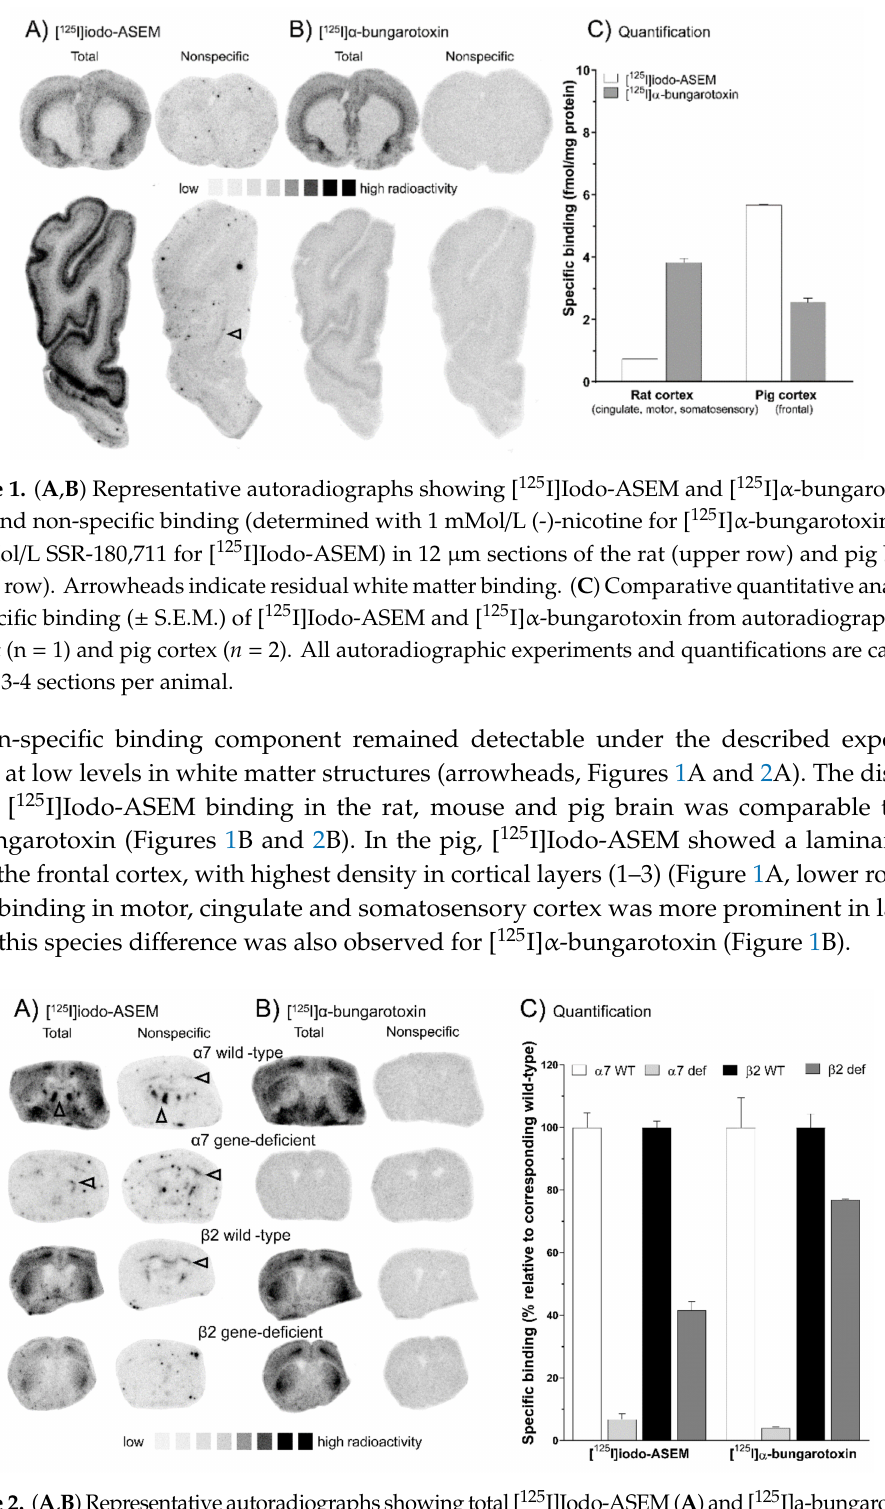
Figure 2. ( A , B )Representativeautoradiographsshowingtotal[ 125 I]Iodo-ASEM( A )and[ 125 I]a-bungarotoxin ( B ) and non-specific (determined with 1 mMol / L (-)-nicotine for [ 125 I] α -bungarotoxin and 10 µ Mol / L SSR-180,711 for [ 125 I]Iodo-ASEM) binding in 12 µ m brain sections of α 7 and β 2 nAChR wild-type vs. corresponding gene-deficient (def) mice ( n = 1 each). Arrowheads indicate residual white matter binding. ( C ) Comparative quantitative analysis of specific binding ( ± S.E.M.) of [ 125 I]Iodo-ASEM and All autoradiographic experiments and quantifications are carried out in 3-6 sections per